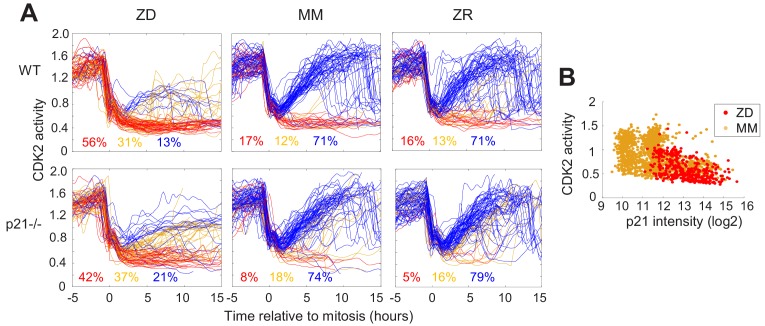
Quiescence induced by Zn2+deficiency does not require p21.(A) Single cell CDK2 traces of WT (top) and p21-/- (bottom) MCF10A cells grown in either ZD, MM, or ZR media. Plots show n = 120 random traces selected from eight individual wells. CDK2 traces were aligned computationally to mitosis and colored by cell fate classifications. % total traces classified into each category are listed below traces (calculated from total traces n = 410, 3275, 3445 for WT cells grown in ZD, MM, and ZR, respectively and n = 441, 764, and 659 for p21-/- cells). (B) CDK2 ratio vs. p21 intensity in WT MCF10A cells at a fixed timepoint after 40 hr of growth in ZD or MM media. p21 was detected with an anti-p21 antibody (for ZD, n = 412 cells pooled from three wells; for MM, n = 1414 cells pooled from three wells).